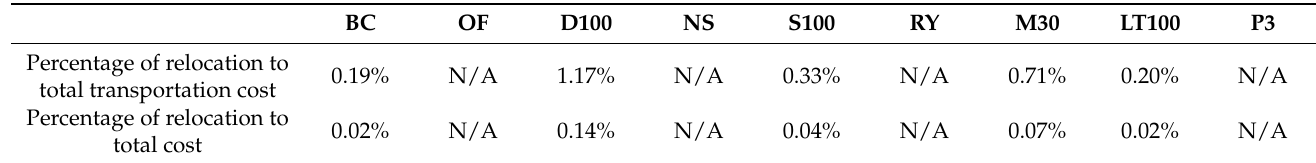
Table 3. Percentage contribution of relocation cost to transportation and total